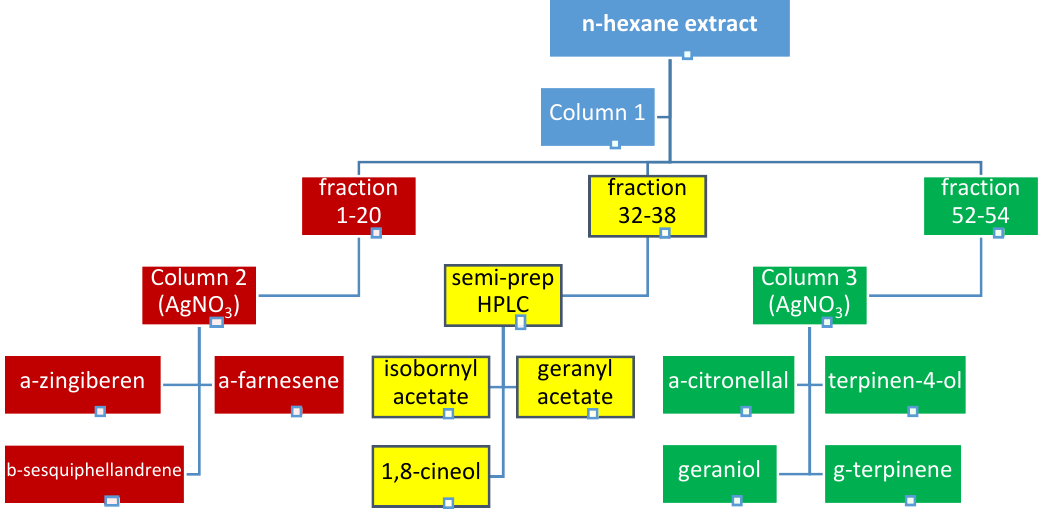
Figure 3. The scheme of bioguided fractionation of the total extract (CC—column chromatography).